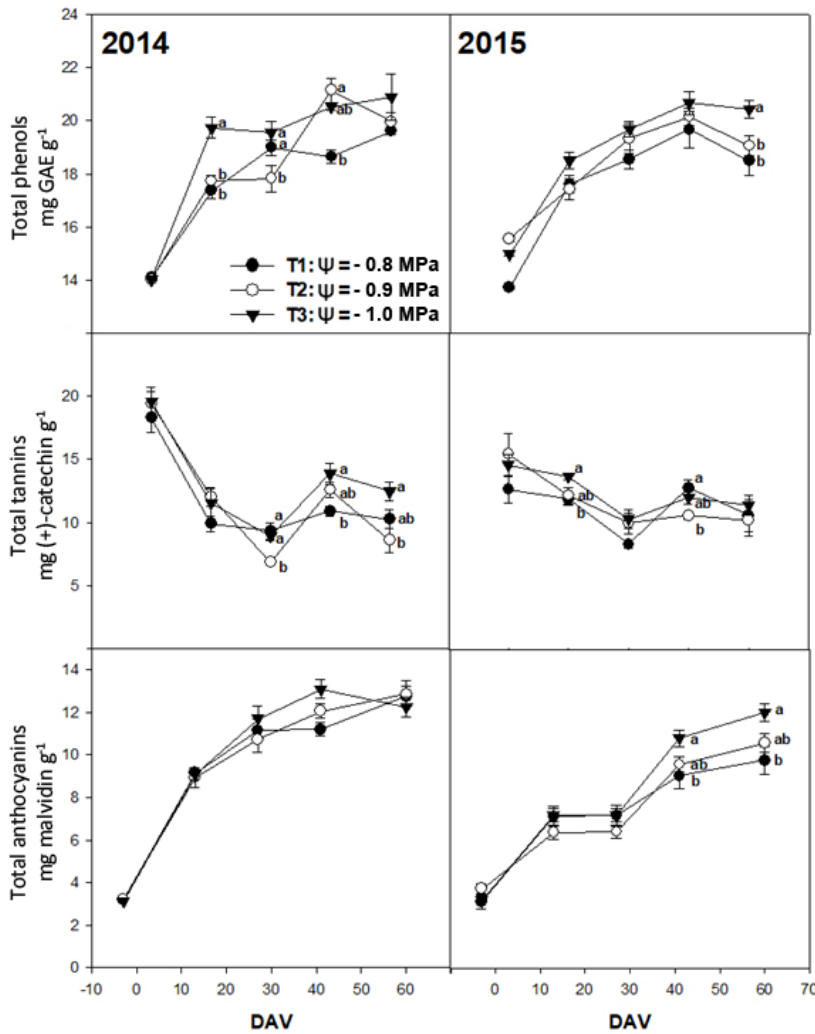
Figure 1. Total phenols, tannins and anthocyanin concentrations in Cabernet Sauvignon grape skins throughout ripening in the 2014 and 2015 seasons. Vertical bars indicate standard error from five replicates. Different letters indicate significant differences between treatments (Tukey’s HSD test, p < 0.05).